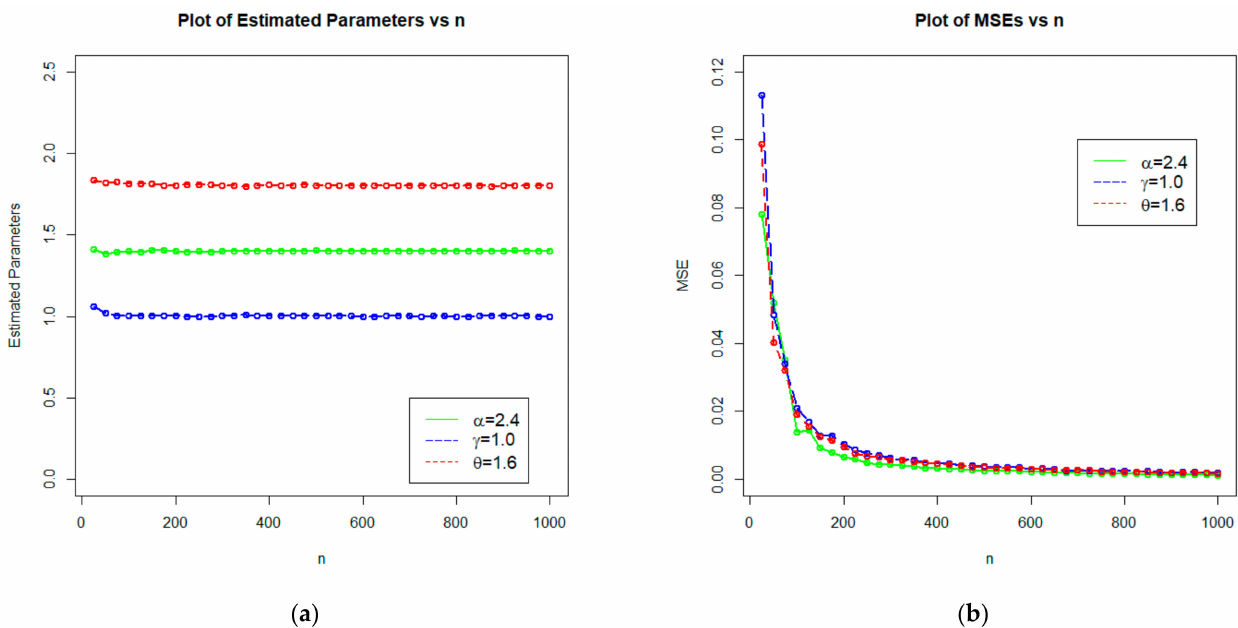
Figure 5. Plots of ( a ) estimated parameters vs. n, and ( b ) MSEs vs. n for Set 1: α = 1.4, γ = 1.0, θ = 1.6.